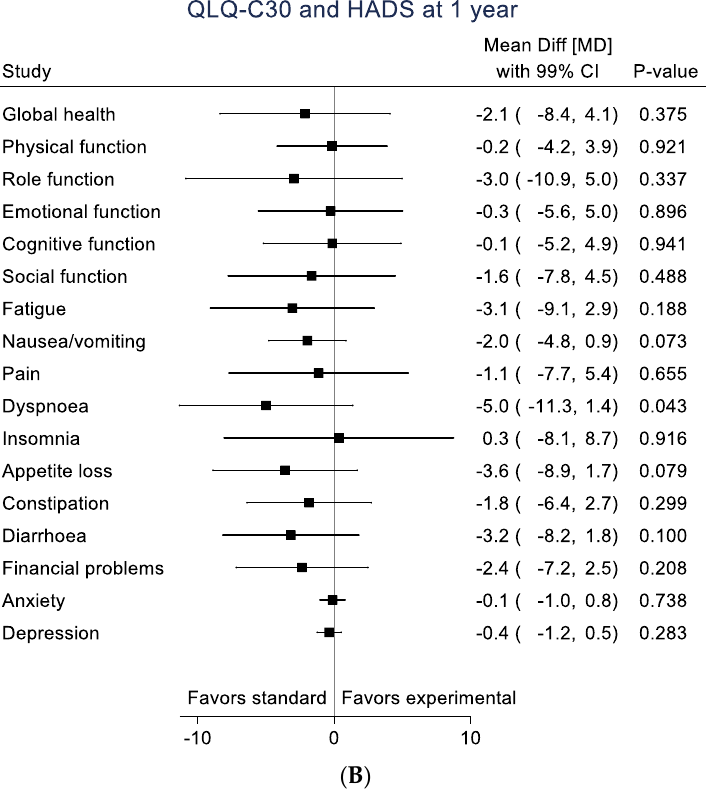
Figure 2. Black squares represent mean differences for each subscale with 99% CI. ( A ). QLQ − C30, HAD − A and HAD − D at baseline. ( B ). QLQ − C30, HAD − A and HAD − D at 1 year. Moreover, neither at baseline nor at the 1-year follow-up were there any statistically significant differences in HRQoL subscales between the total study group and expected values in the general population when comparing baseline data to age- and sex-adjusted Cancers 2022 , 14 , x normative data for the Swedish population (Figure 3).